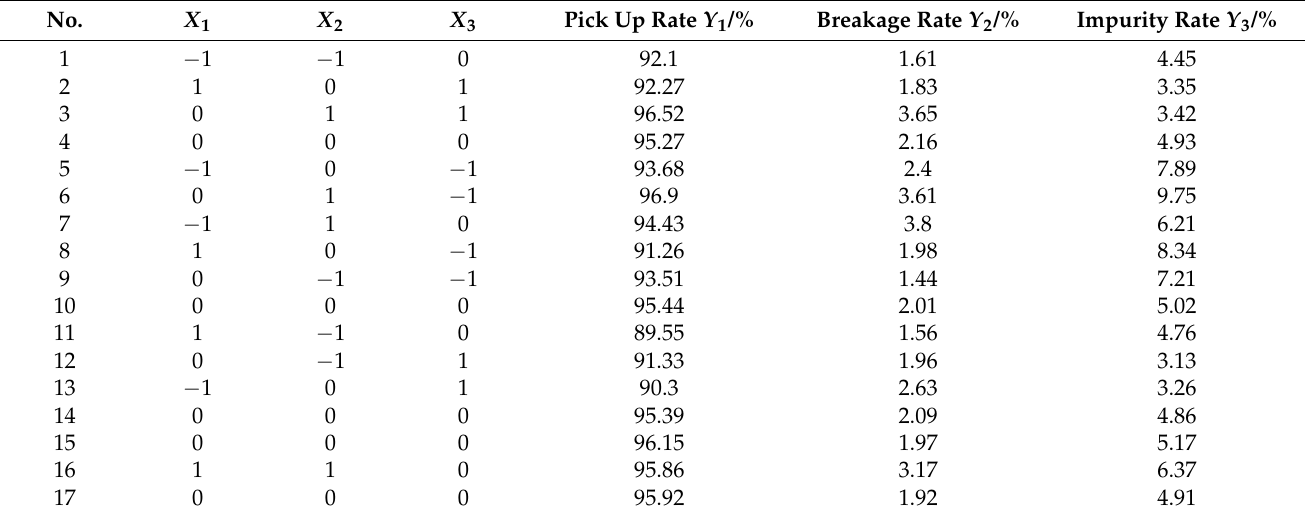
Table 4. Test design and results of pickup jujubes on the ground.